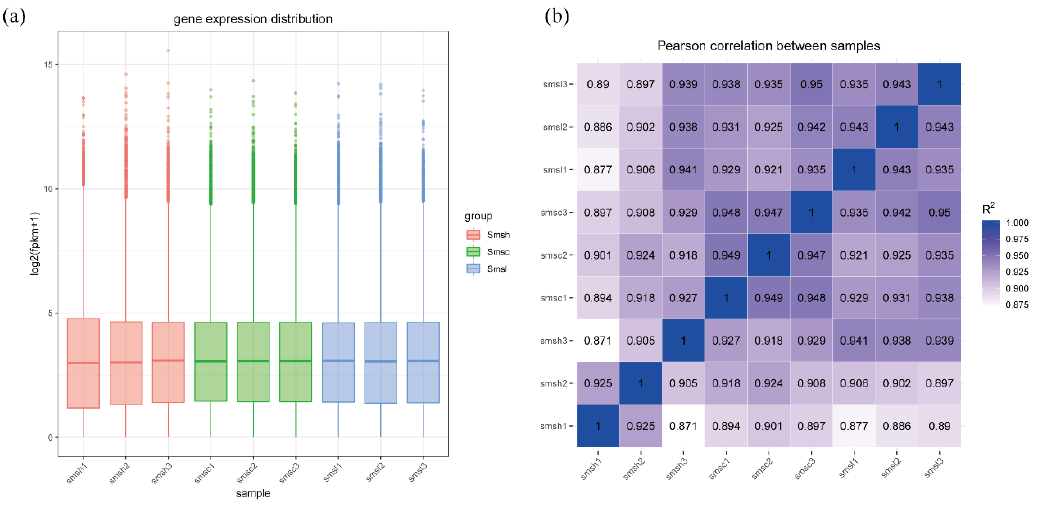
Figure 1. Expression level analysis diagram. ( a ) Gene expression box diagram (Table S1: Gene_fpkm). ( b ) Sample correlation heatmap of gene expression (Table S2: